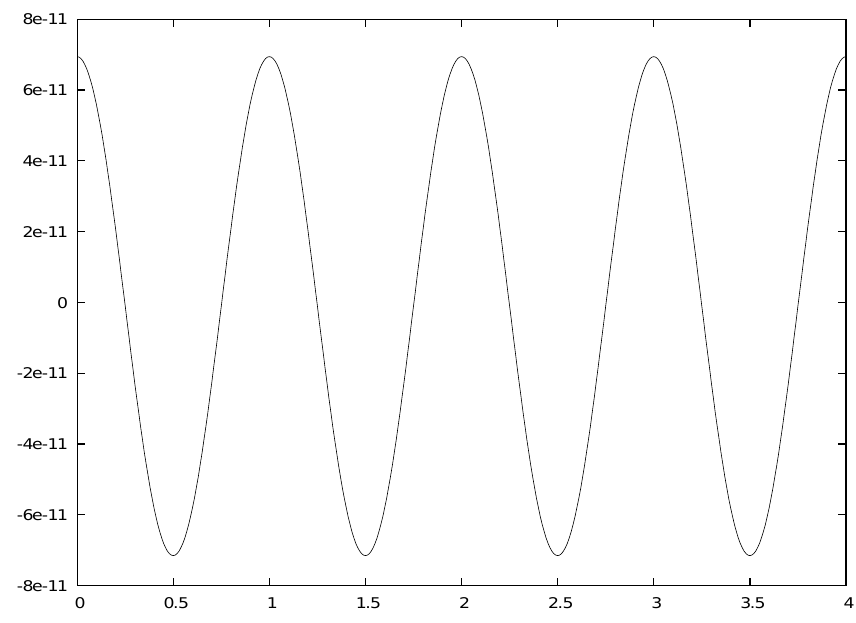
y , determined by 2